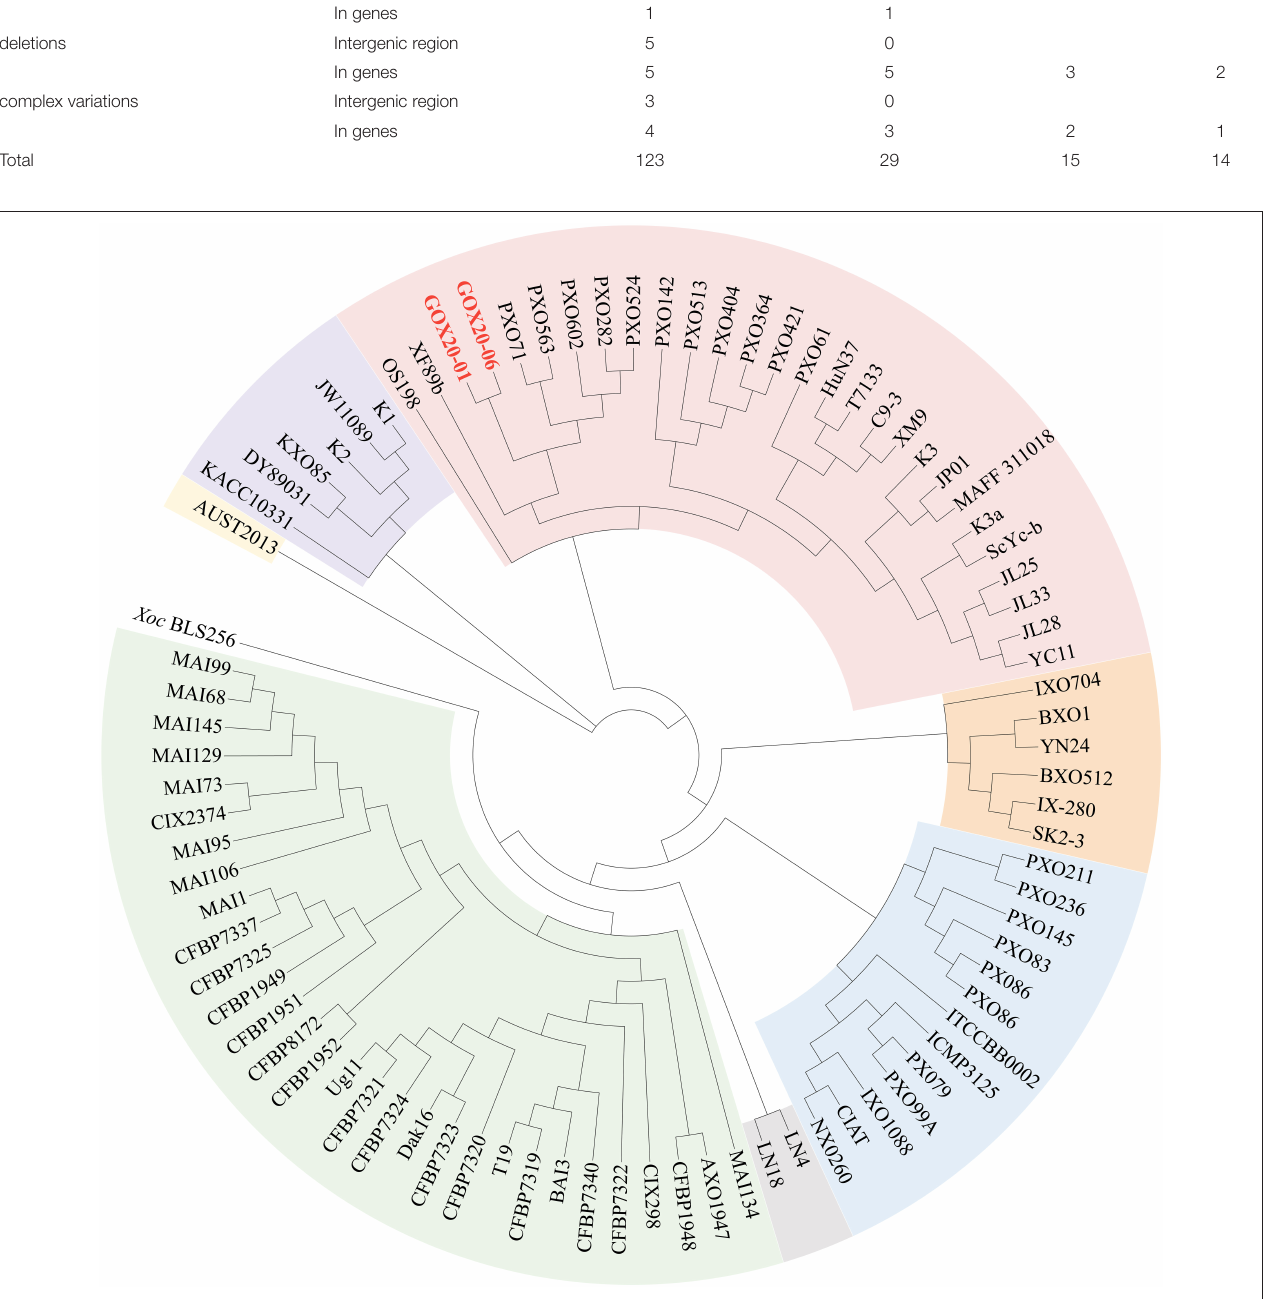
FIGURE 3 | Phylogenomic analysis of Xoo strains based on genome sequences of representative Xoo strains. The genome sequences were obtained from NCBI. The tree was annotated and visualized by using CVTree3 web server. The phylogenetic trees by using the NJ method. The K-tuple length is 6.